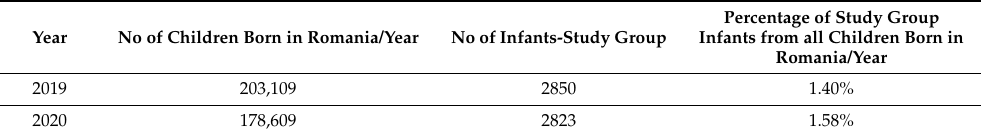
Table 2. Study group demographic